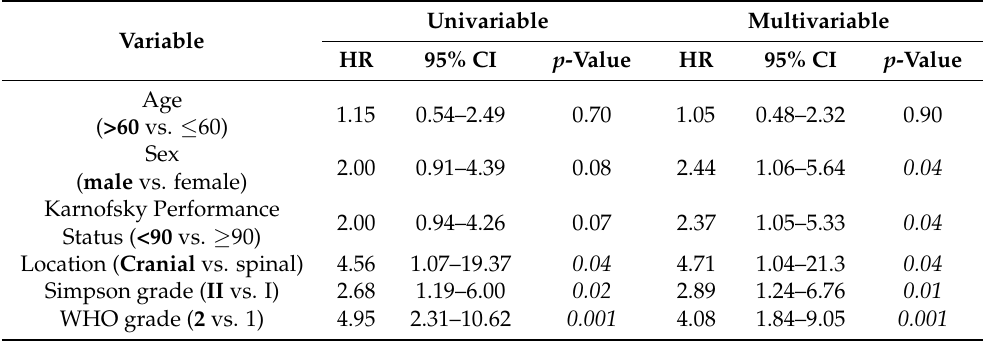
Table 4. Uni- and multivariable Cox regression analysis of progression-free survival in WHO grade 1 and 2